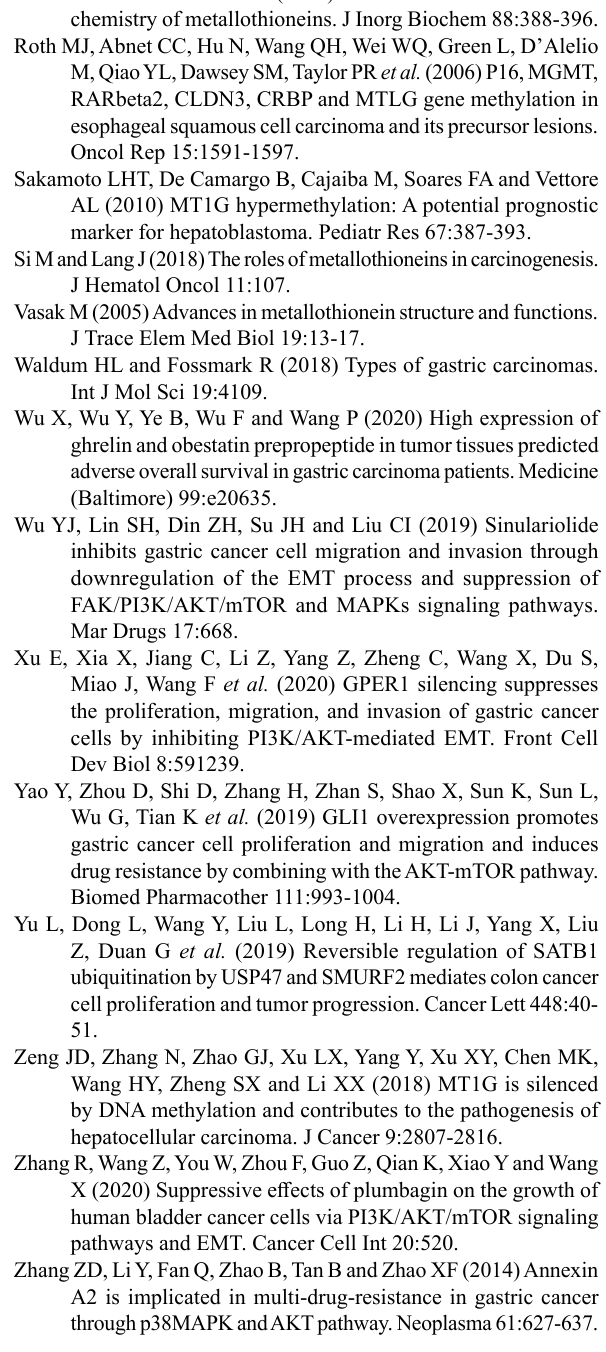
Figure S1 – MT1G inhibits cell cycle progression of GC cells. Figure S2 – MT1G negatively regulates cell migration and